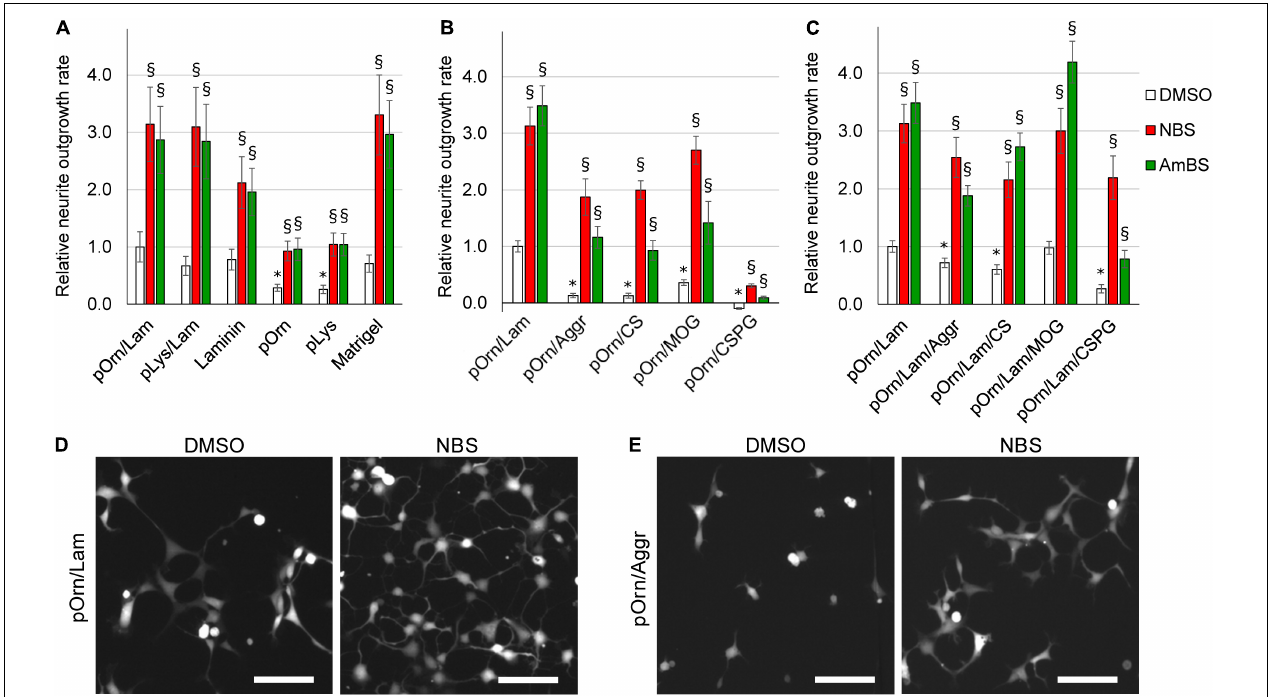
FIGURE 4 | Effect of various extracellular matrices on the neurite outgrowth. (A) Human NPCs were seeded onto culturing plates coated with permissive ECM components, such as laminin, poly-ornithine (pOrn), poly-lysine (pLys), Matrigel, the combination of poly-ornithine and laminin (pOrn/Lam), or the combination of poly-lysine and laminin (pLys/Lam). Neurite outgrowth was monitored in the presence and absence of 10 µ M para-nitroblebbistatin (NBS) or 20 µ M para-aminoblebbistatin (AmBS). The neurite outgrowth rates were determined from the initial growth rates. The neurite outgrowth rate measured in cells seeded onto pOrn/Lam-coated surface was used as a reference point, and all growth rates were normalized to this value. (B) Neurite outgrowth rates were determined in NPCs plated onto coatings containing poly-ornithine (pOrn) in combination with restrictive ECM components, including aggrecan (Aggr), chondroitin-sulfate (CS), myelin oligodendrocyte glycoprotein (MOG), or chondroitin-sulfate proteoglycan (CSPG). As a reference point, the neurite outgrowth rate of cells on pOrn/Lam-coated surface was used. All four ECM components inhibited neurite outgrowth of NPCs. When the cells were treated with NBS or AmBS extensive neurite outgrowth was observed except for the cells seeded onto pOrn/CSPG-coated surface. (C) An experiment similar to that shown in (B) was performed with the difference that laminin was also included in the coatings. In this combination, MOG was not detrimental to the cells, and BS derivatives were able to override the inhibitory effect of not only Aggr and CS, but also of CSPG. In all panels, the mean ± SEM from at least three independent experiments are indicated. Asterisks indicate significant differences as compared to the samples grown on pOrn/Lam-coated surface, whereas section signs mark significant differences as compared to untreated samples (vehicle controls, white columns) ( p < 0.05). (D) Morphology of NPCs seeded onto pOrn/Lam-coated surface and treated with vehicle (DMSO) or 20 µ M NBS for 4 h. (E) Representative images of NPCs seeded onto pOrn/Aggr-coated plate and treated with DMSO or 20 µ M NBS for 4 h. Scale bars indicate 10 µ